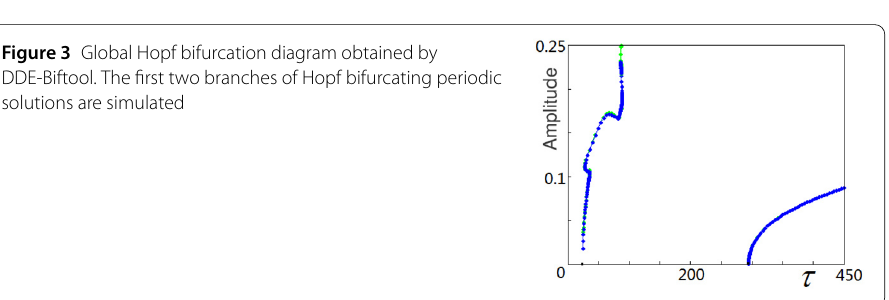
Figure 3 Global Hopf bifurcation diagram obtained by DDE-Biftool. The first two branches of Hopf bifurcating periodic solutions are